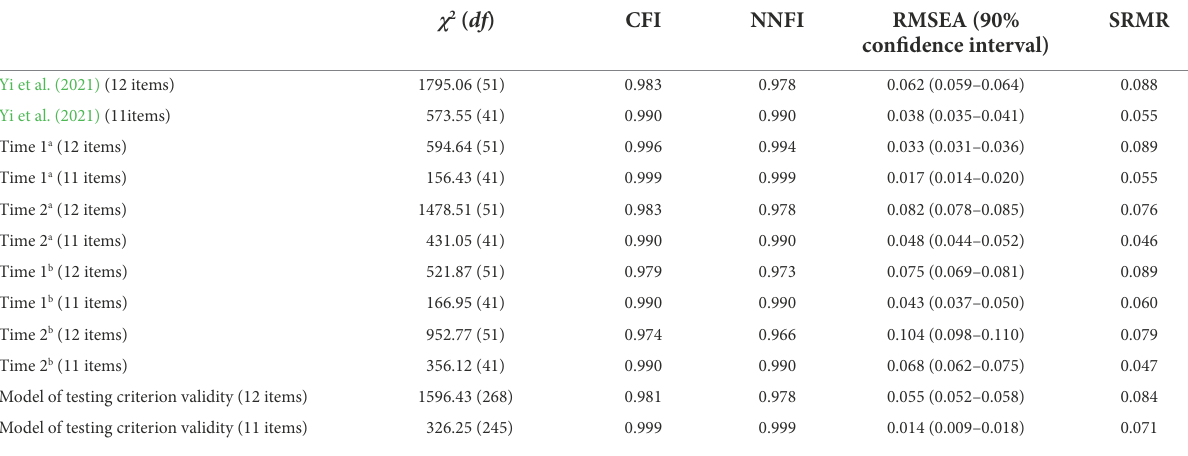
TABLE 3 Results of model fit.